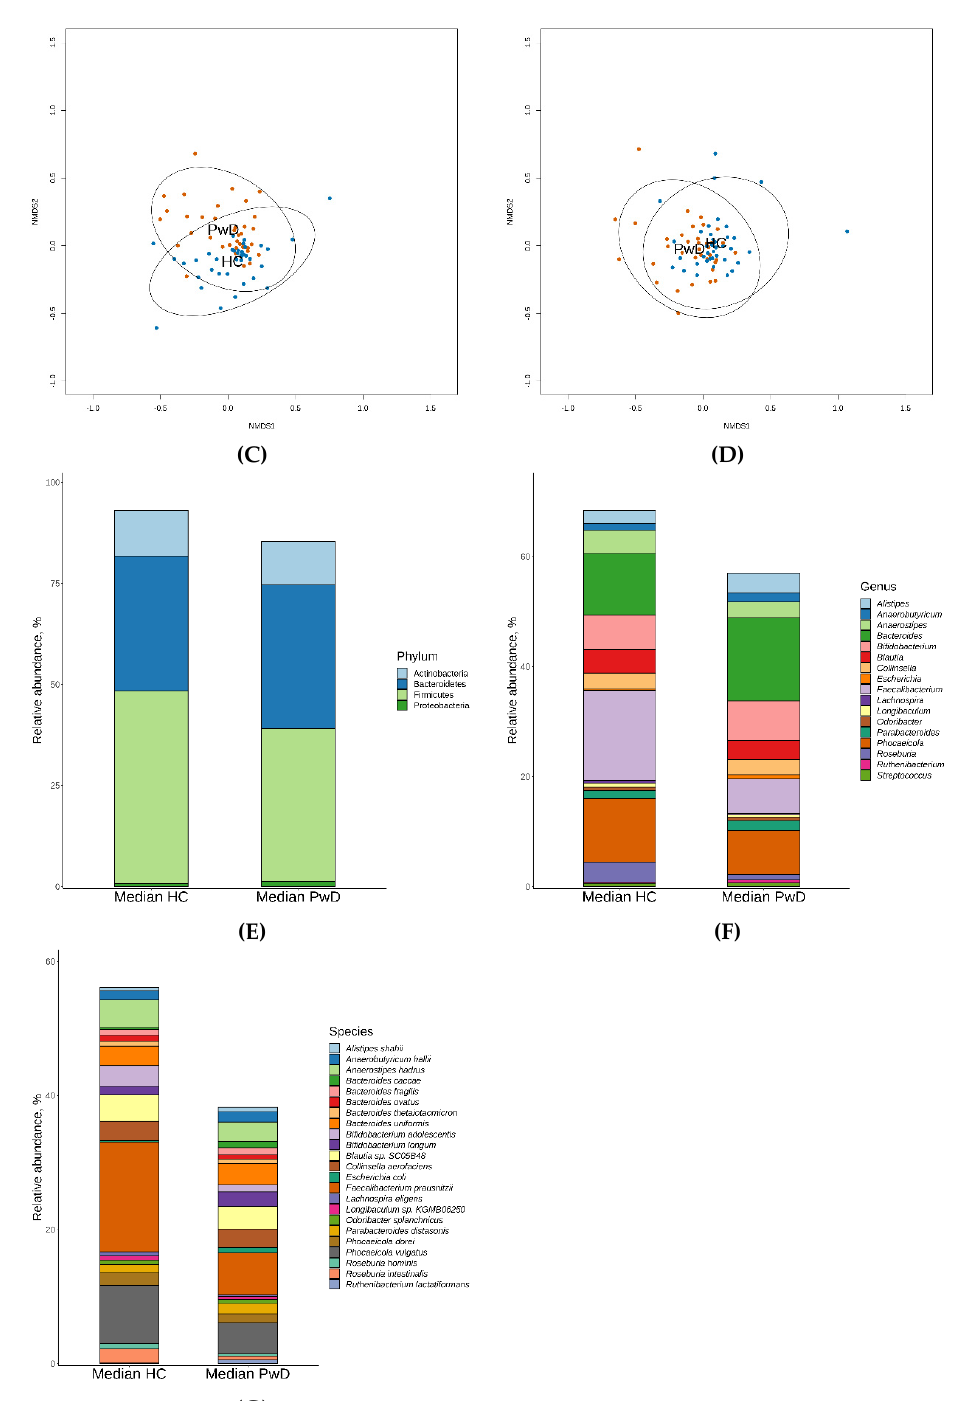
Figure 2. Diversity analysis of GM of MDD patients and healthy controls. ( A , B ): comparison of Shannon indexes between the HC and PwD groups at ‘Genus’ and ‘Species’ taxonomic levels, respectively. ( C , D ): nMDS plots describing beta-diversity between the HC and PwD groups at ‘Genus’ and ‘Species’ taxonomic levels, respectively. The points representing HC are colored in blue and PwD group are colored in red. Ellipses indicate confidence areas around the clusters of grouped samples. ( E – G ): taxa with median relative abundance > 0.5% detected in GM of the HC and PwD groups at ’Phylum’, ‘Genus’, and ‘Species’ levels, respectively. Median values of relative abundances are stated in percentages. Full taxonomic profiles are provided in Supplementary Table